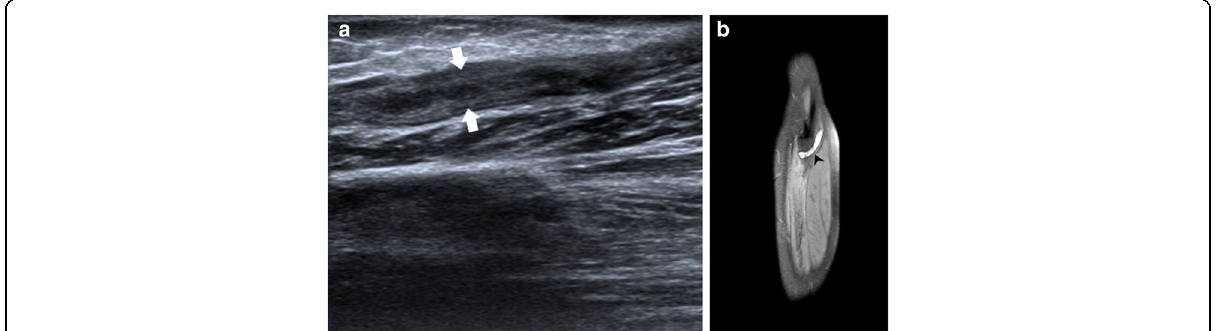
Fig. 14 a Longitudinal scan of ulnar nerve at the elbow (arrowheads) shows a thickened nerve with loss of fascicular architecture. There was also increased vascularity suggestive of neuritis in this patient with Hansen ’ s disease. b PDFS sagittal image shows a tubular hyperintense CPN (arrowhead) as it winds around the fibular neck in a case with Hansen ’ s disease. There is long segment thickening, loss of fascicular architecture with incidentally detected high division of the sciatic nerve. There was also associated fatty infiltration with muscle hyperintensity due